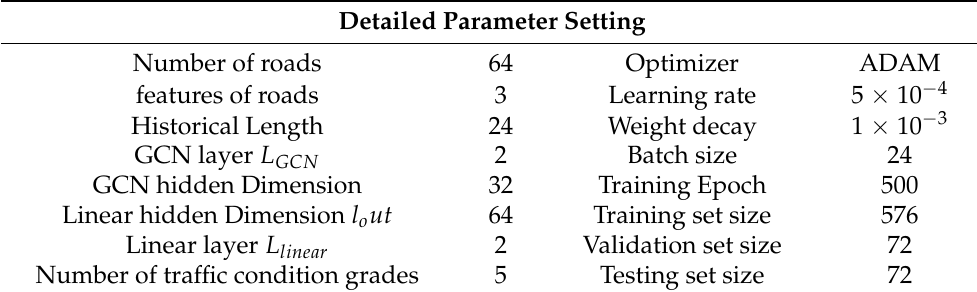
Table 1. Hyperparameter setting for Environment